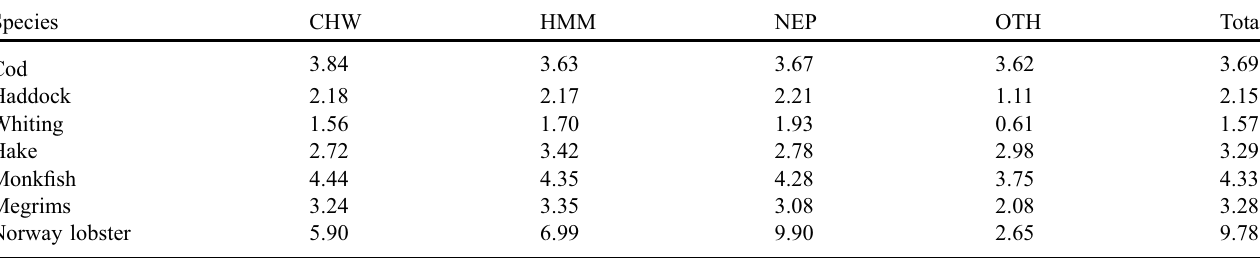
Table A.4. Average price ( € /kg) by the polyvalent general fl eet segment þ 18m of the main species within each fi shery (cod, haddock, whiting